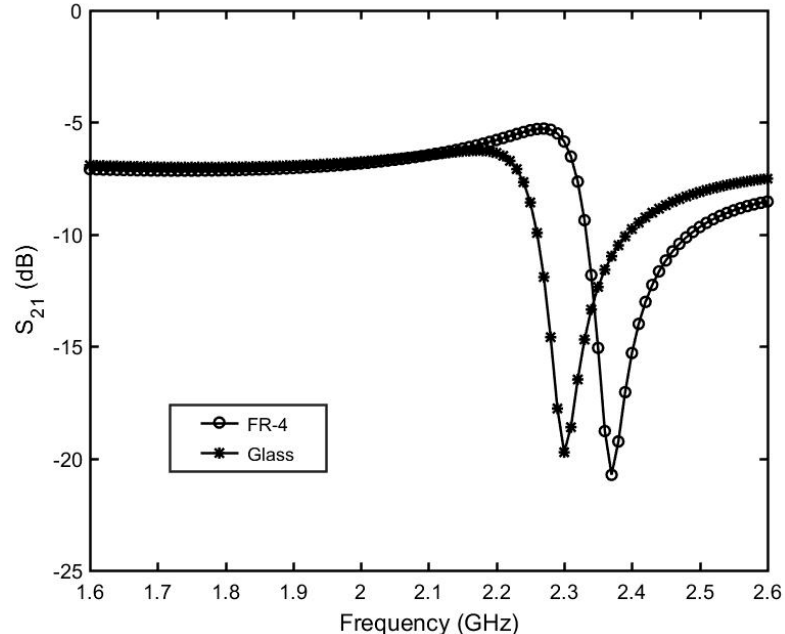
Figure 8. Transmission coefficient (S 21 ) simulated results as a function of the resonance frequency of the sensor for different MUTs.